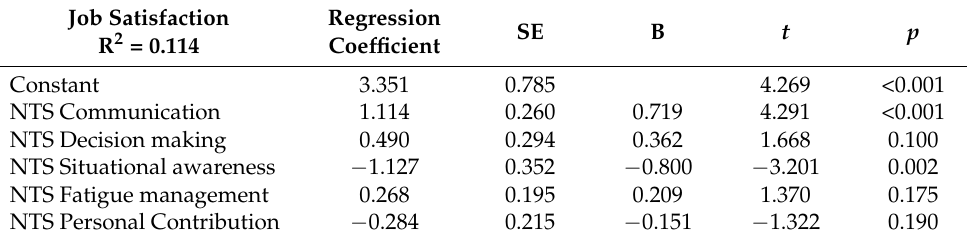
Table 5. Model 3—NTS, Multiple linear regression for physicians’ job satisfaction ( n = 78). Job Satisfaction R 2 = 0.114